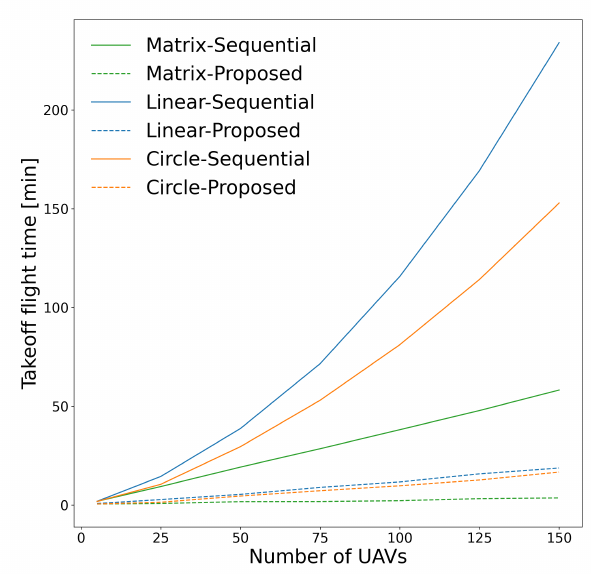
Figure 21. Comparison of the take-off flight time against the semi-simultaneous and sequential pro-